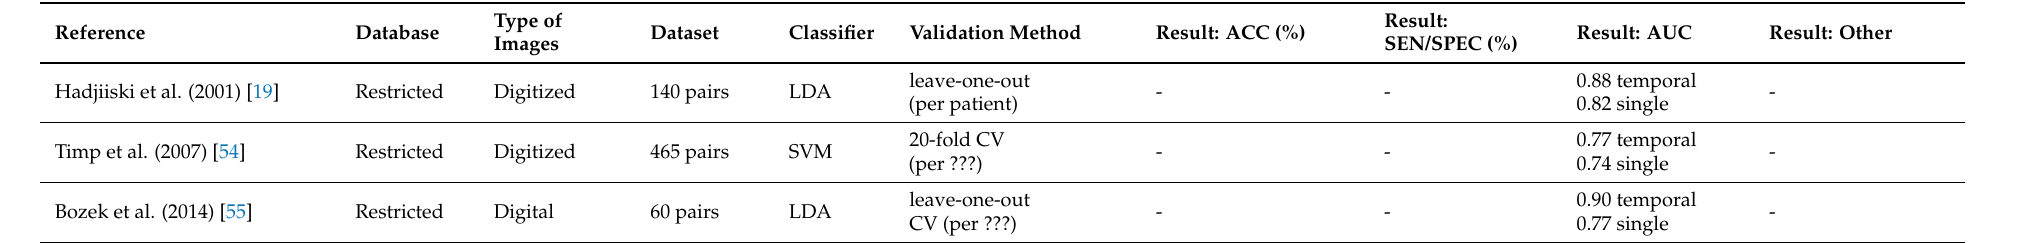
Table 4. Comparison of algorithms for the classification of masses in sequential mammograms using temporal analysis and feature-based machine